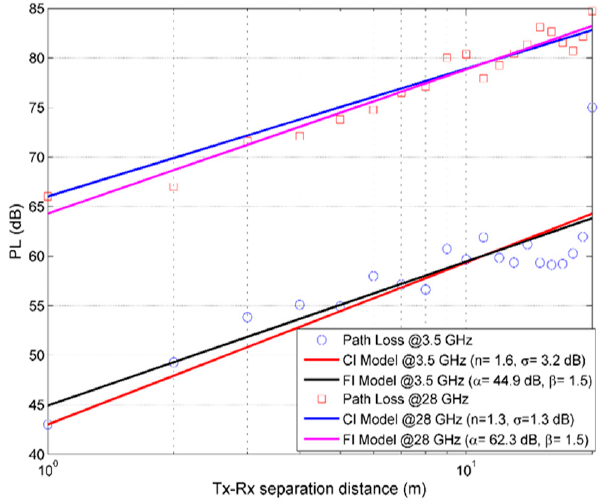
Figure 4. Path loss CI and FI models fitting versus Tx-Rx separation distance at 3.5 GHz and 28 GHz for LOS scenario.